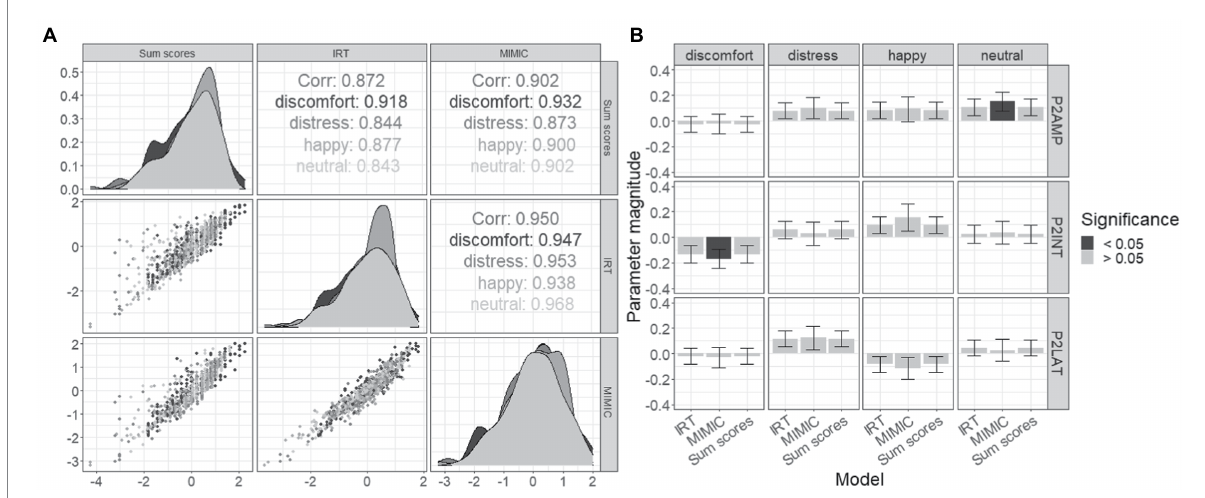
FIGURE 5 Comparison of MIMIC model and two-stage results. (A) Displayed are correlations of iDemo battery summarization which include the two-stage sum-scores, a two-stage IRT, and finally the MIMIC model. (B) Magnitude of formative relationships is plotted (+/ − SE), with significant effects distinguished from nonsignificant effects based on the bar’s